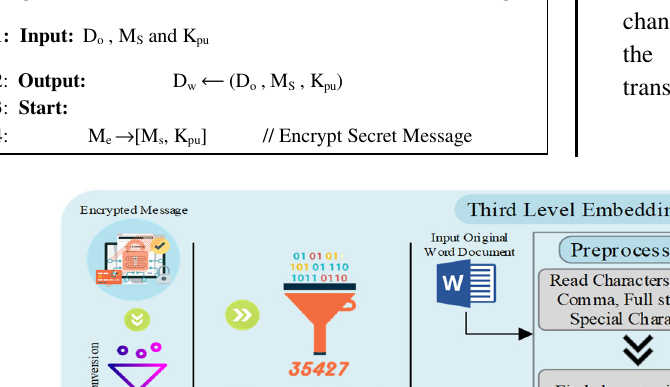
embedded into selected open spaces. Algorithm II watermark embedding in document’s open spaces. Algorithm II: Second Level Watermark Embedding 1: